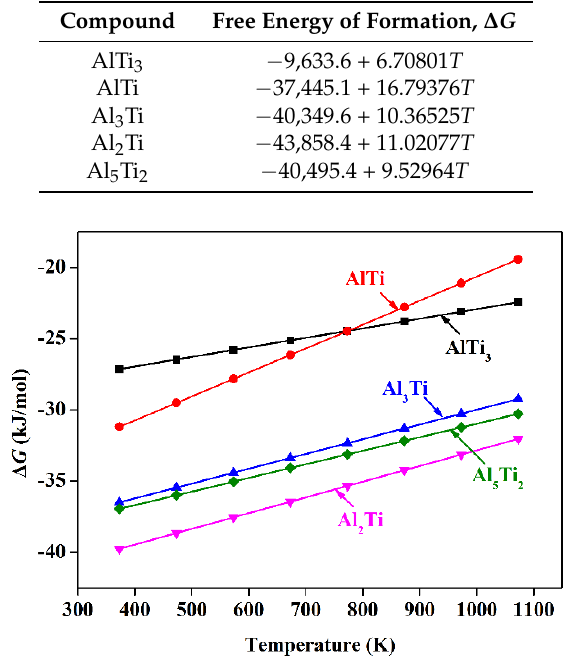
Table 2. Temperature dependence of Gibbs free energy of formation of various Ti-A1 compounds, data from ref. [21].